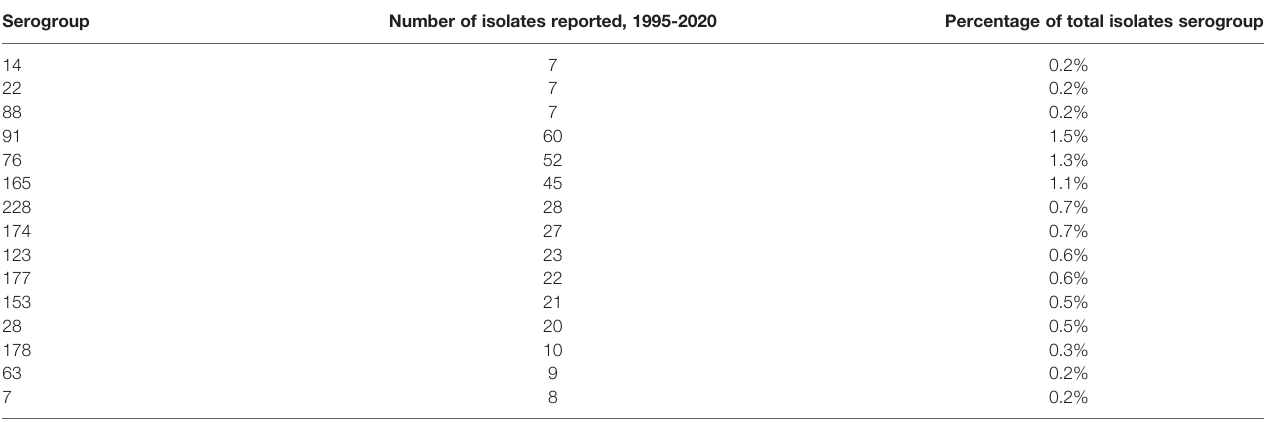
TABLE 1B | Non-O157 STEC isolates characterized at the National Escherichia coli Reference Laboratory, by serogroups.